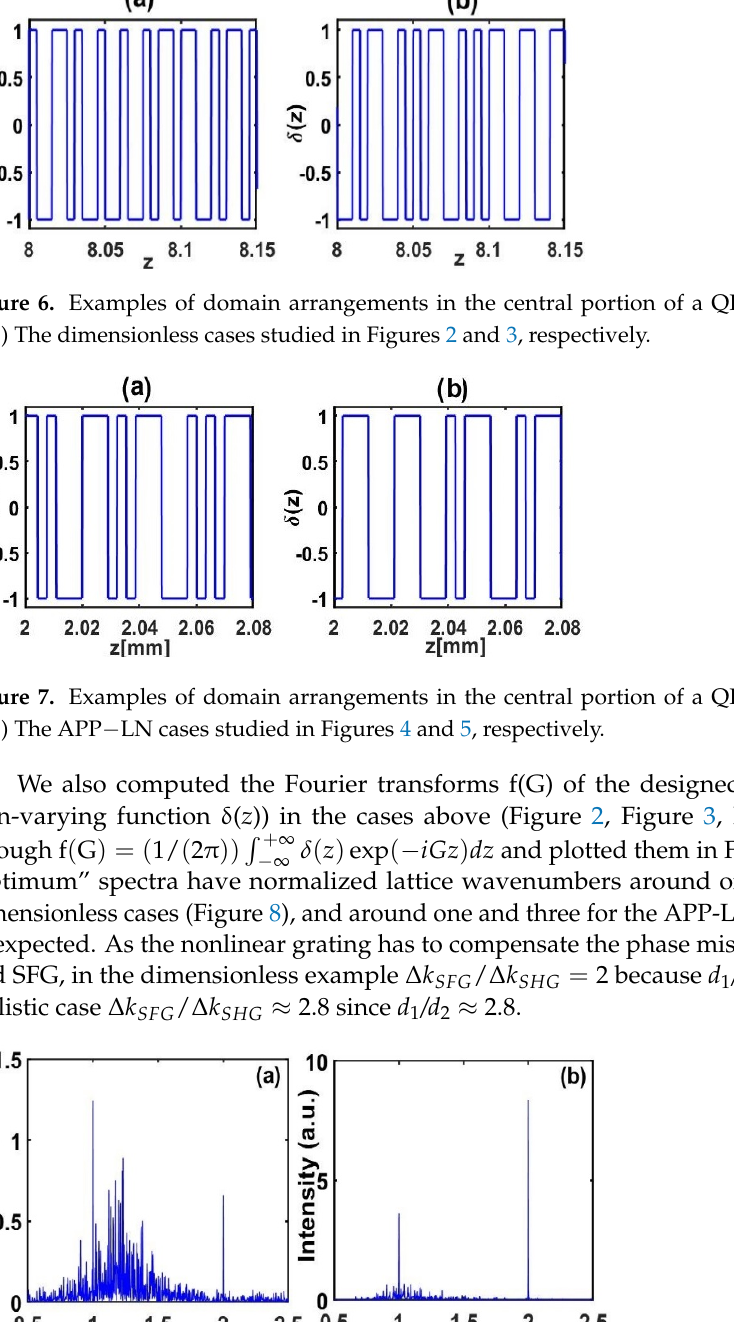
Figure 9. The Fourier transforms of the δ (z) functions of the designed nonlinear lattices. ( a , b ) refer to the APP − LN crystal for ( a ) different (Figure 4) or ( b ) equal (Figure 5) domain sizes in each seg ‐ ment. Finally, we studied the dependence of the conversion efficiency η 3 on the input in ‐ tensity at the fundamental frequency, which is of relevance in view of actual experimental measurements. To this extent, we considered the realistic case of a QPM dual lattice in the APP − LN crystal with equal domain sizes in each segment, as discussed above (see Figure 5). Figure 10 shows some typical results for three values of input power densities, as spec ‐ ified on each line. Clearly, high conversion efficiencies to the third harmonic can be ob ‐ tained despite intensity variations as large as 100% with respect to the nominal excitation (Figure 5).